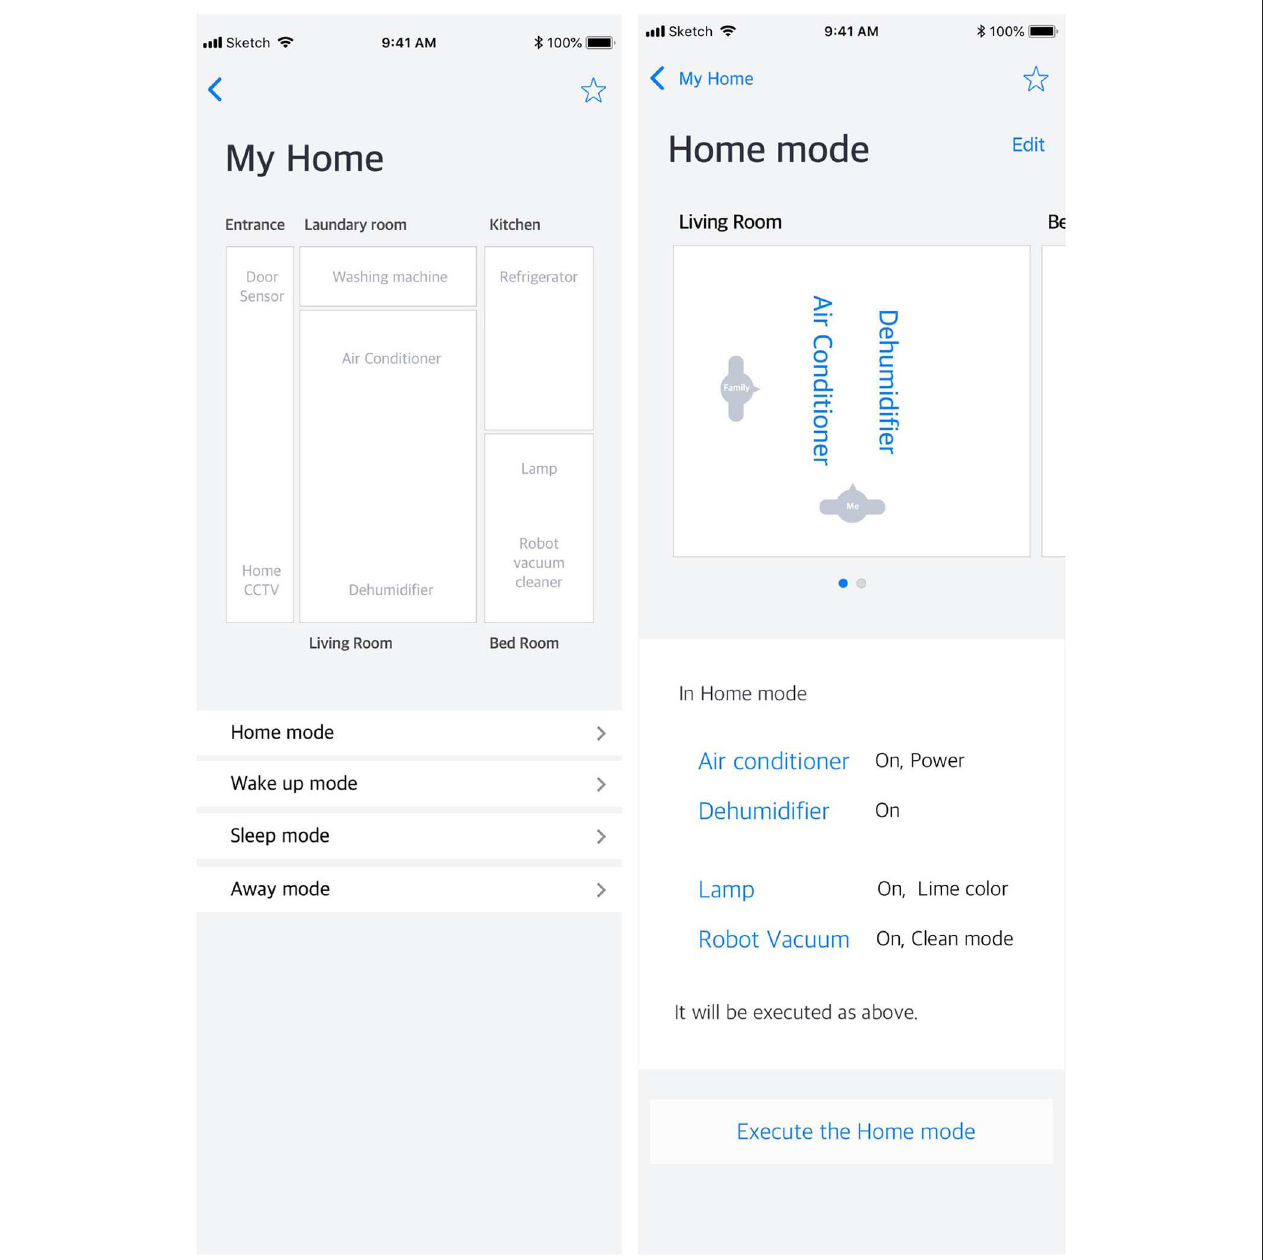
FIGURE 3 | Screenshots of a mock smart home mobile application interface in Experiment 2. There were four different situation lists n the main page (Left) and there was information about the location, status, and context of the smart home devices in the sub-list page (Right) .